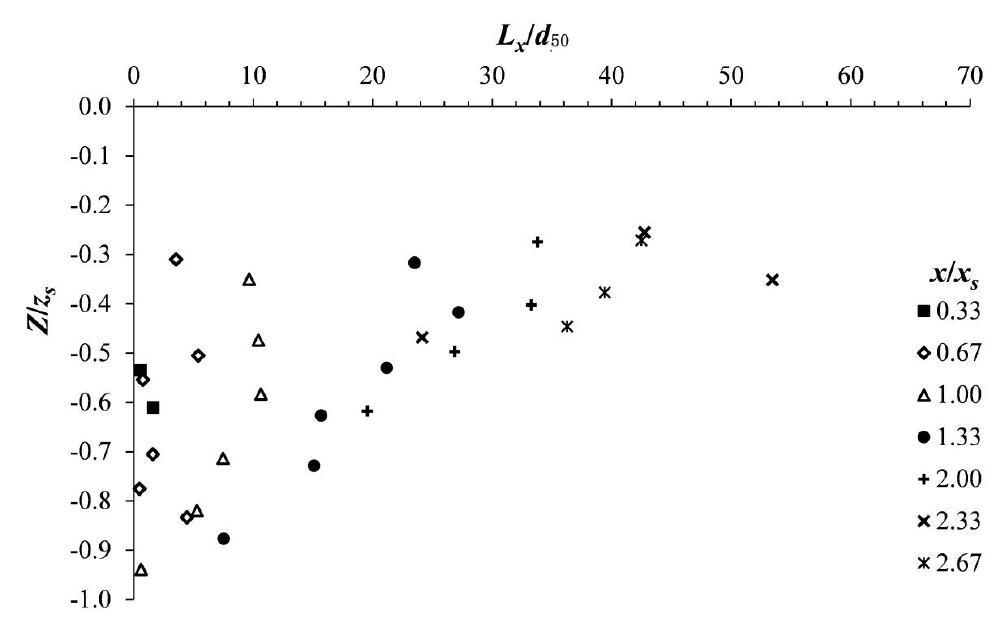
Figure 7. Vertical profiles of normalized turbulent length scales, L x / d 50 , at di ff erent downstream positions x / x s at the plane of flow symmetry ( y = 0).